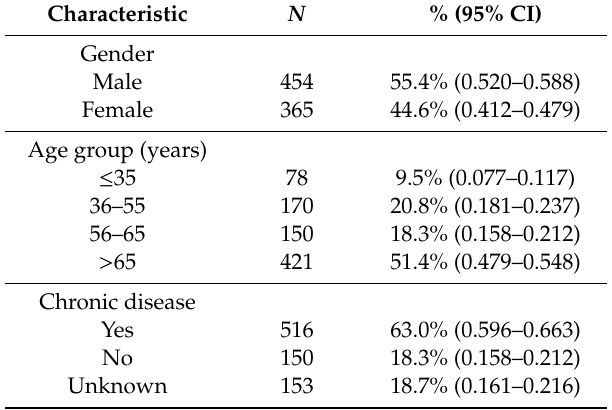
Table 1. Characteristics of the 819 enrolled patients in the Emergency Department (23 March–21 April).